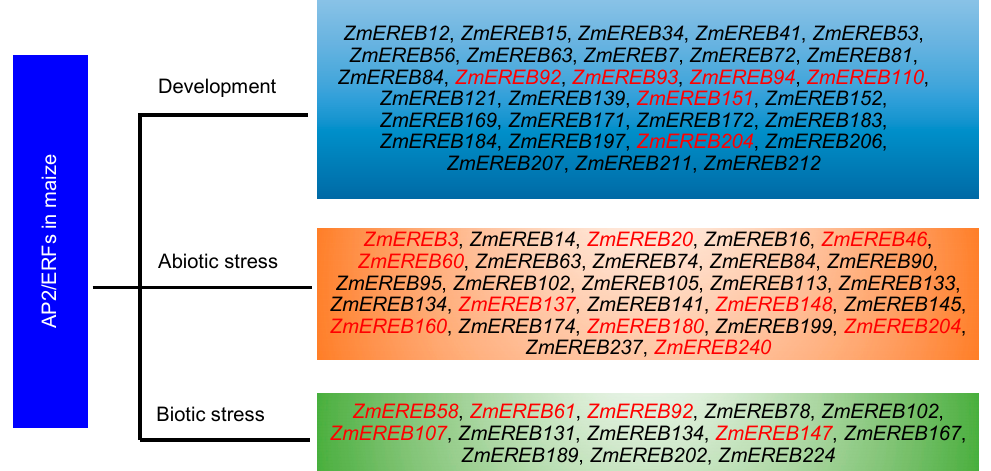
Figure 4. The candidate AP2/ERFs are putatively involved in the development, abiotic and biotic stress. The genes with red color represented the cloned category in maize, and the genes with black color represented the predicted category based on rice homologs.